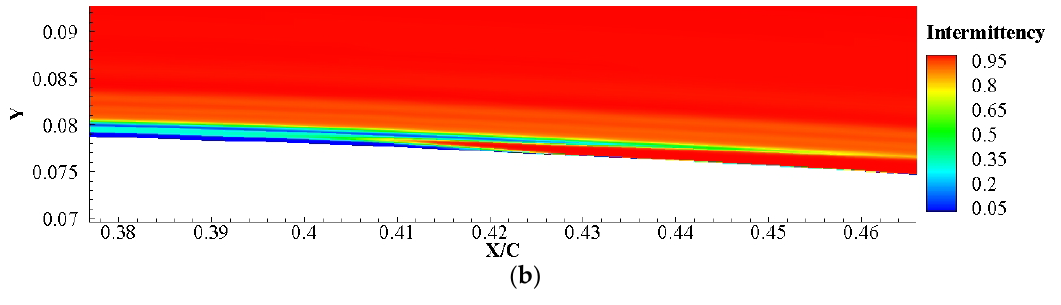
Figure 11. Transition of the viscous boundary layer shown on ( a ) a schematic diagram that complies well with ( b ) the intermittency contour obtained numerically at the transition region.